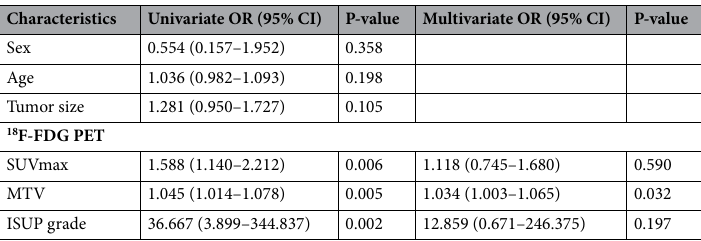
Table 2. Univariate and multivariate analyses for pathological T